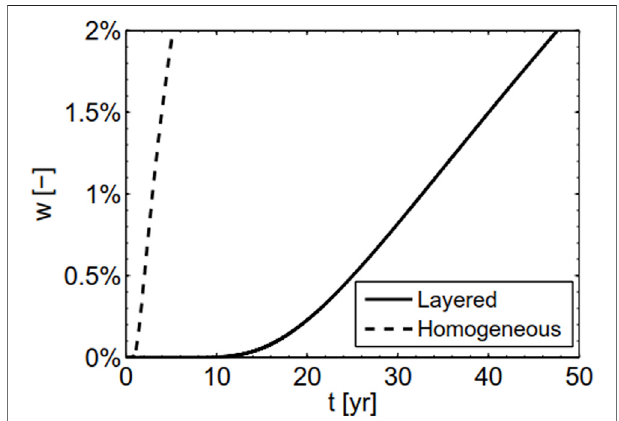
FIGURE 4 | The breakthrough curves of pumped water in the homogeneous (dashed line) and layered (solid line) cases. The layered case is the same case as in Figure 2 .